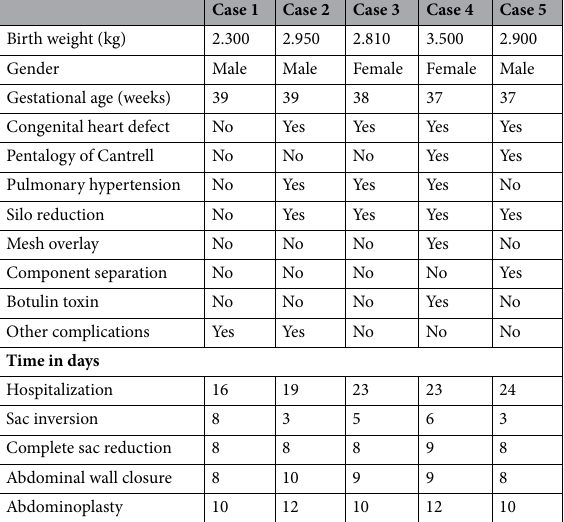
Table 5. Summary table of the clinical characteristics of the infants who